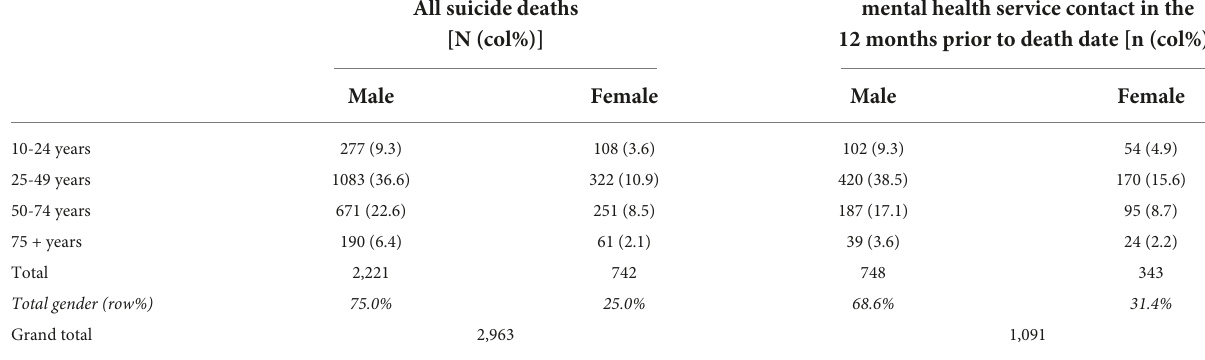
TABLE 1 Total suicide deaths and suicide deaths with at least one mental health related service contact, Victoria 2012-2016.